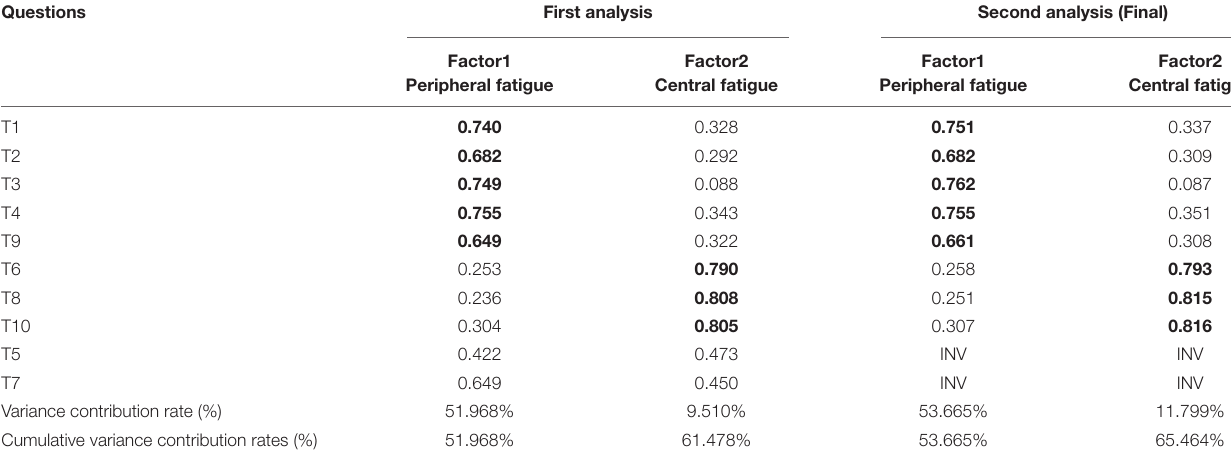
TABLE 3 | The loadings of exploratory